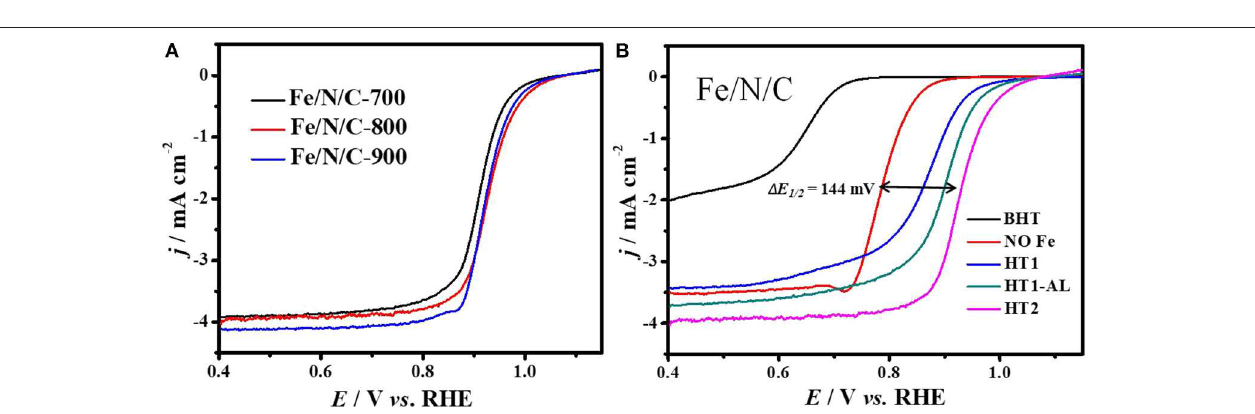
FIGURE 6 | ORR polarization curves of Fe/N/C electrocatalysts (A) electrocatalysts synthesized at different temperatures, (B) electrocatalysts at different synthesis stages in O 2 -saturated 0.1M NaOH solution at a scan rate of 10mV s − 1 , 900 rpm.